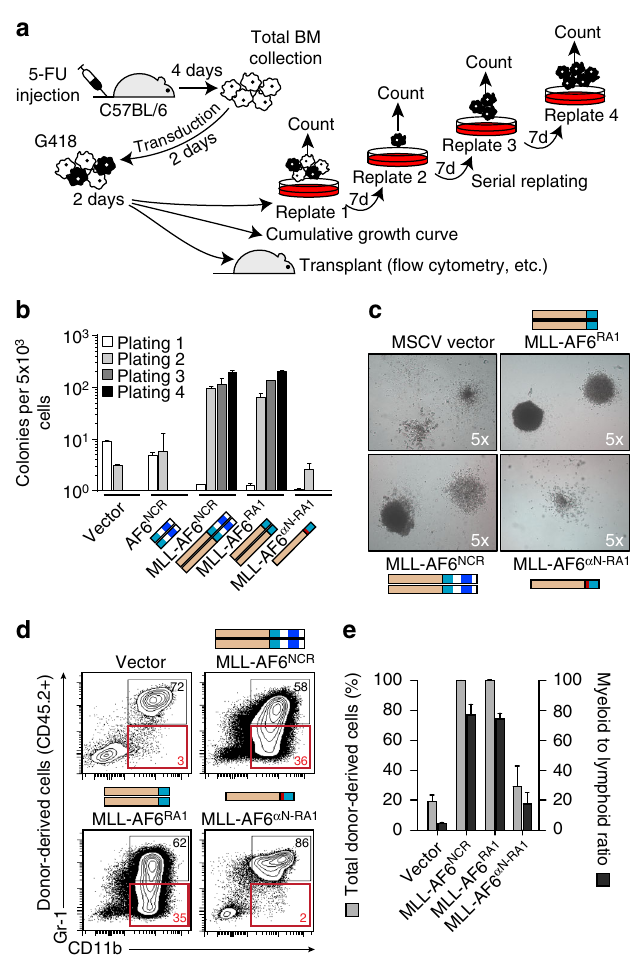
Fig. 4 Insertion of the α N helix between MLL and AF6 disrupts myeloid immortalization and blocks its leukemogenic potential in mice. a Schematic of experimental strategies to measure immortalization of hematopoietic progenitors and induction of leukemogenesis. b Serial replating immortalization assay for progenitor cells transduced with retroviral constructs. Bars represent mean ± SD of the total colonies per 5 × 10 3 cells derived from three replicates. c Typical granulocyte and macrophage colonies from primary methylcellulose cultures of pMSCVneo or MLL- AF6 α N-RA1 and macroscopic blast colonies from MLL-AF6 NCR or MLL- AF6 RA1 cultures. d Representative fl ow cytometry analysis of donor-derived myeloid cells in the bone marrow of transplanted mice. The red quadrants highlight the immature CD11b + GR1 low/negative myeloid subpopulation which was signi fi cantly expanded in MLL-AF6 NCR or MLL-AF6 RA1 expressing bone marrow cells in primary transplants compared to control cells (vector) and MLL-AF6 α N-RA1 expressing bone marrow cells. All mice transplanted with MLL-AF6 NCR or MLL-AF6 RA1 expressing cells were leukemic at 5 weeks ( > 20% blasts in the bone marrow and peripheral blood) while MLL- AF6 α N-RA1 expressing cells did not induce leukemia up to 10 weeks after transplantation. e Donor-derived engraftment in the bone marrow of mice transplanted with 10 5 BM cells transduced with pMSCVneo, MLL-AF6 NCR , MLL-AF6 RA1 or MLL-AF6 α N-RA1 . BM cells were selected for 7 days in G418 prior to transplantation. Shown are the mean ± SD of donor cell engraftment (CD45.2 + ) and of the myeloid (CD11b+, Gr1+) to lymphoid (CD3+, B220+) ratio in donor-derived cells 5 weeks after transplantation (2 × 10 5 /mice, n = 5 or 7 mice). Error bars represent